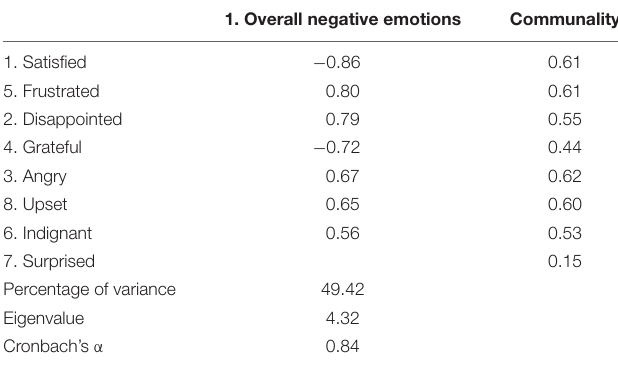
TABLE 6 | Factor loadings based on an exploratory factor analysis with a principal axis factoring and direct oblimin rotation on eight items measuring emotions ( N =